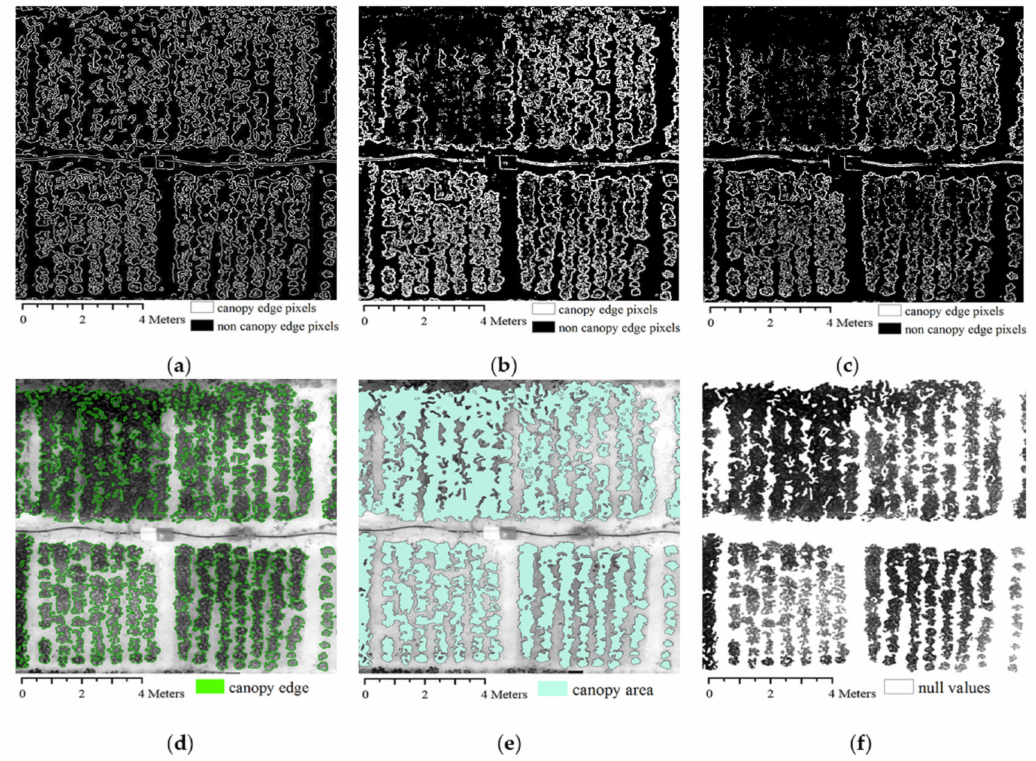
Figure 3. ( a ) Canny edge feature raster image (binary image: the cotton canopy edge pixels are white and the non-canopy edge pixels are black); ( b ) Prewitt edge feature raster image; ( c ) Roberts edge feature raster image; ( d ) Cotton canopy polyline vector layer; ( e ) Cotton canopy polygon vector layer; ( f ) Cotton canopy raster clip